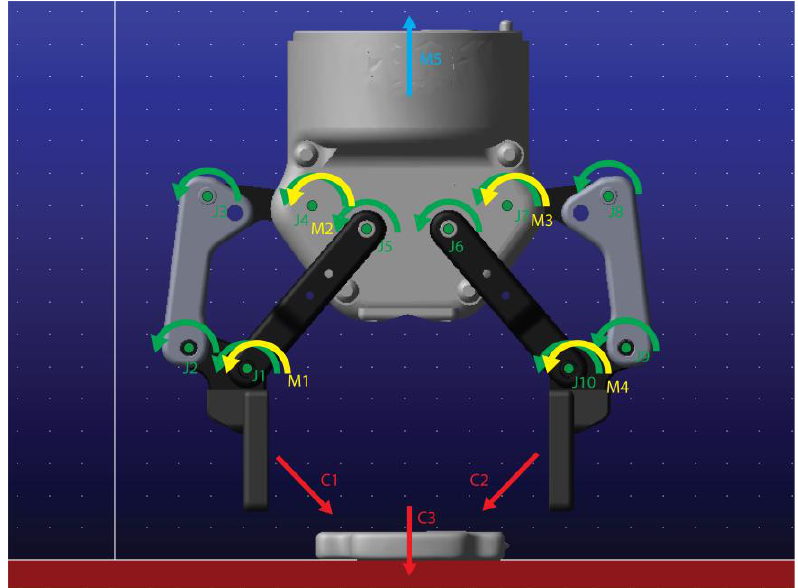
Figure 2. Model of robotic gripper and the object to be gripped in ADAMS/View. Green arrows (J1 – J10) indicate revolute joints, yellow arrows (M1 – M4) show rotational motions, cyan arrow (M5) indicates general motion (translation and orientation of the gripper), and red arrows indicate three different contacts used (C1 – C3). Source: own.